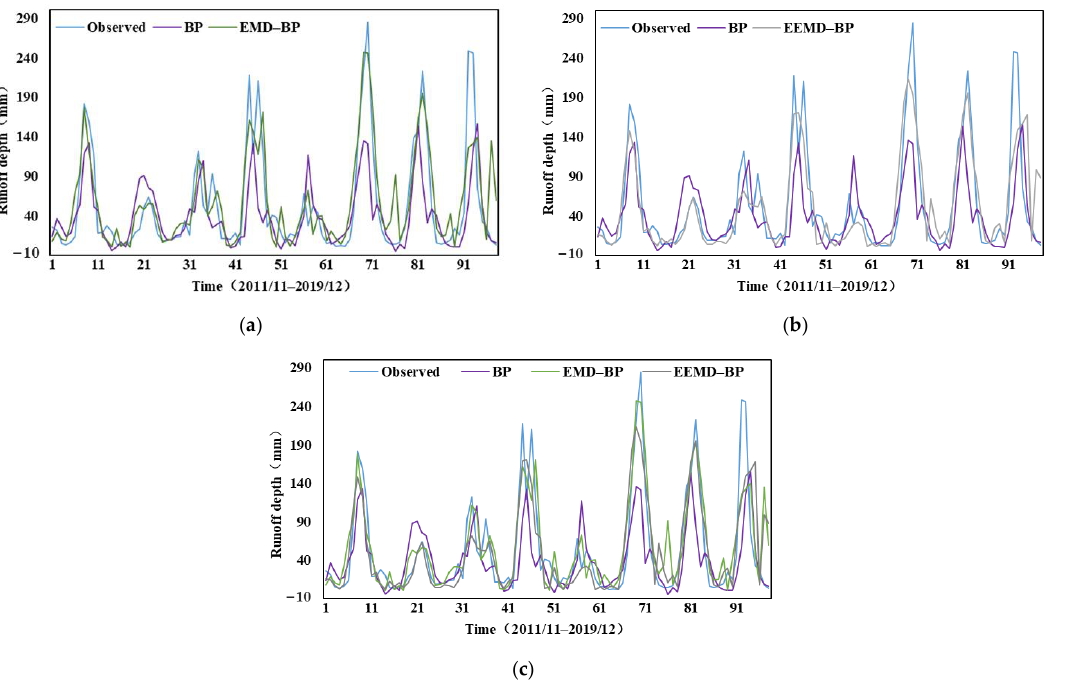
Figure 7. Forecasted and observed monthly streamflow during the validation period by the BP model, based on EMD and EEMD pre-processing techniques. ( a ) Prediction results of EMD – BP model. ( b ) Prediction results of EEMD – BP model. ( c ) Prediction results of EMD – BP model, and EEMD – BP model.